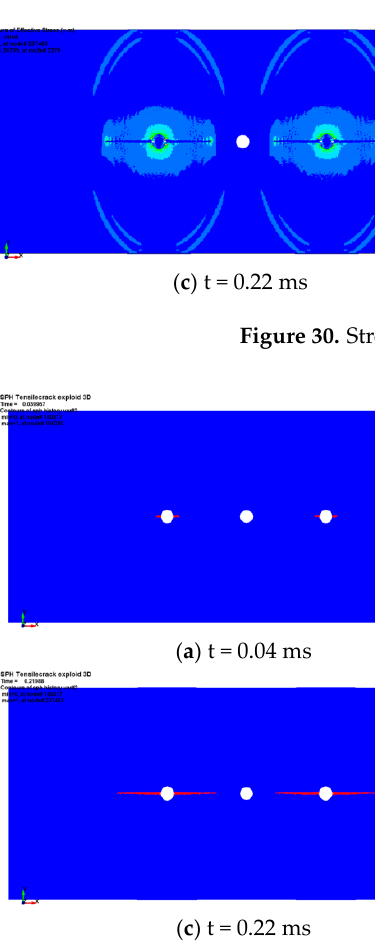
Figure 31. Development process of cracks caused by spaced-hole blasting with 300 mm spacing.